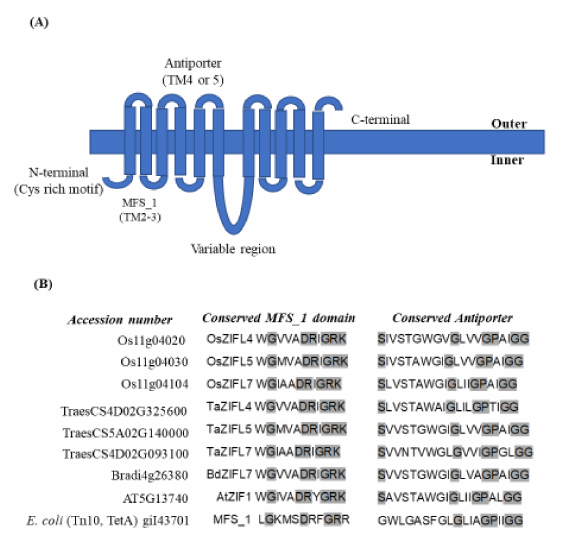
Figure 2. ZIFL family sequence signatures. ( A ) Schematic representation of the ZIFL bearing the MFS_1 signature (cytoplasmic loop between TM2 and TM3: MFS signature) and antiporter signature (TM4/5). ( B ) ZIFL-specific conserved-residue signature domains for MFS and antiporter sequences in rice (OsTOM1-ZIFL4, OsTOM2-ZIFL5 and OsTOM3-ZIFL7); wheat (TaTOM1-ZIFL4.1/4.2, TaTOM2- ZIFL5 and TaTOM3-ZIFL7.1/7.2), Brachypodium ( BdTOM1.1 - Bradi4g26380), Arabidopsis (AtZIF1) and E. coli (MFS_1). The conserved residue for MFS: G-x(3)-D-[RK]-x-G-R-[RK] residues are highlighted, and the Antiporter S-x(8)-G-x(3)-G-P-x(2)-G-G residues are